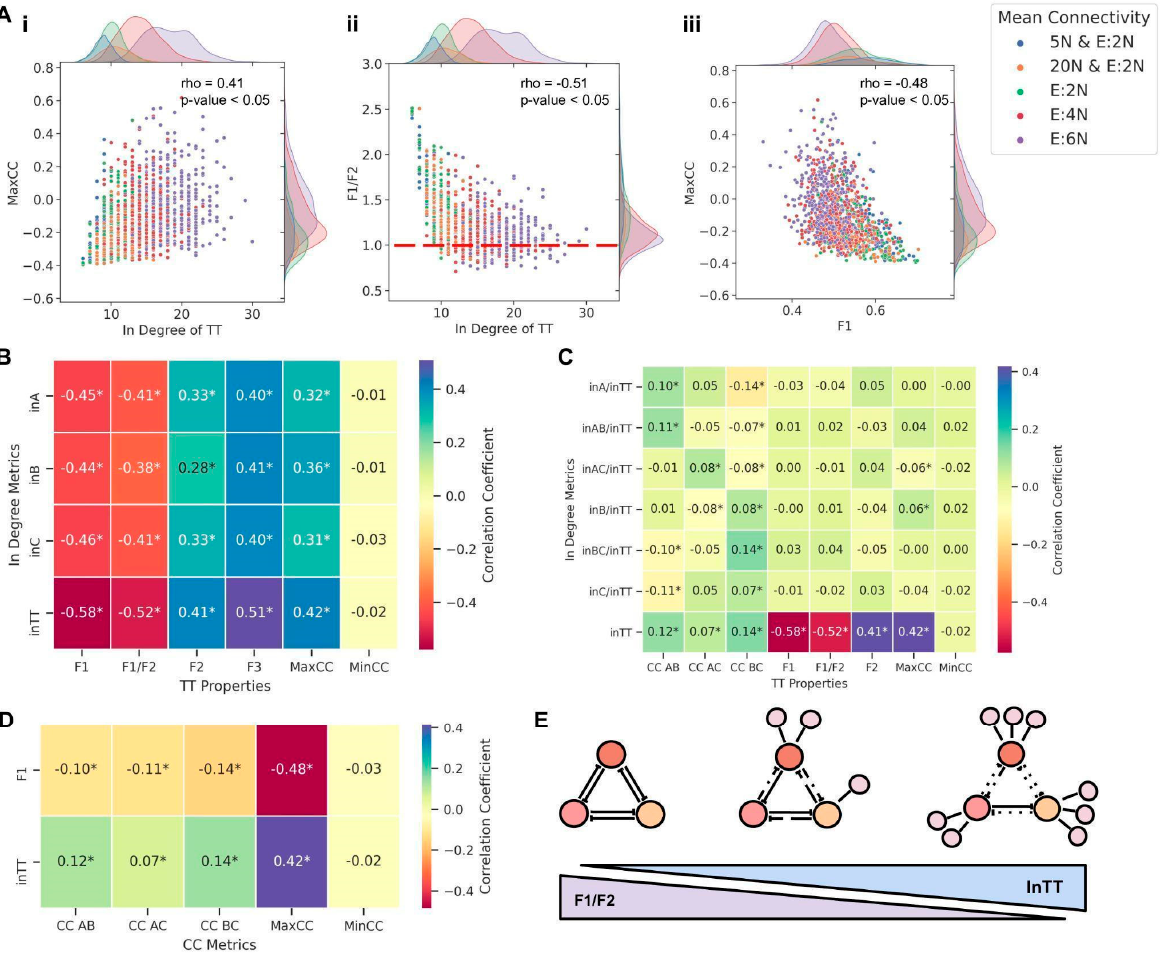
Figure 6. Influence of the in-degree of TT on its dynamics. ( A ) (i) Plot showing the dependence of change in distribution of the MaxCC values with changing in-degree of a TT motif. (ii) Plots showing the dependence of change in the distribution of F1/F2 values with changing in-degree of a TT motif (iii) Plots showing the dependence of change in the distribution of MaxCC with changing F1 values. Each dot is colored according to its respective network mean connectivity. Spearman correlation coefficients (rho) and p -values are given in upper right corner of each plot. ( B ) Heatmap of the pairwise correlation coefficients of in-degree metrics against various TS properties. ( C ) Heatmap of pairwise correlation coefficients of normalized in-degree metrics against various TS properties. In panels B and C. ( D ) Heatmap of the pairwise correlation coefficients of inTT and F1 against various CC metrics. * in heatmap cells signify p -value < 0.05 according to Spearman correlation test. ( E ) Schematic summary of the effect of increase in-degree on the dynamics of a